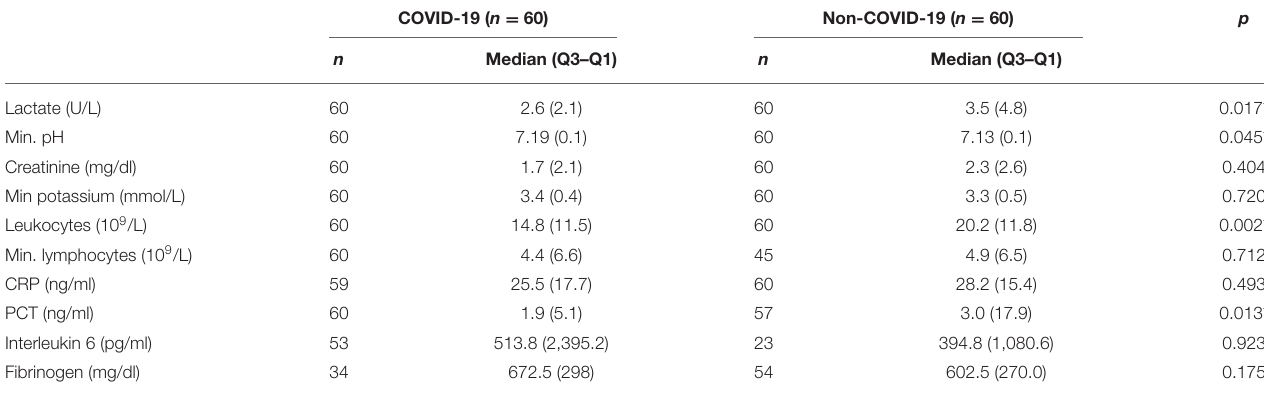
TABLE 4 | Relevant laboratory markers during ICU